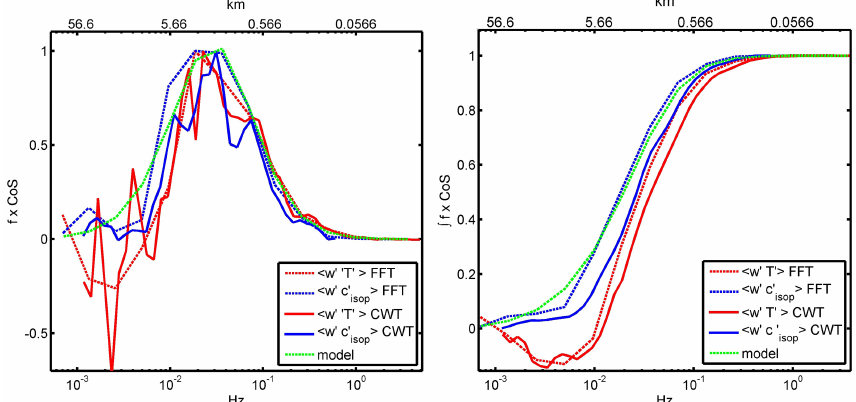
Figure 3. Spectral quality control of the example flight segment. Left panel: comparison of co-spectra for isoprene flux and heat flux using the FFT and CWT methods independently; Right panel: cumulative co-spectra for isoprene flux and heat flux using the FFT and CWT methods independently. The green lines in left and right panels show the model that is used with transfer functions optimized from Kristensen et al.